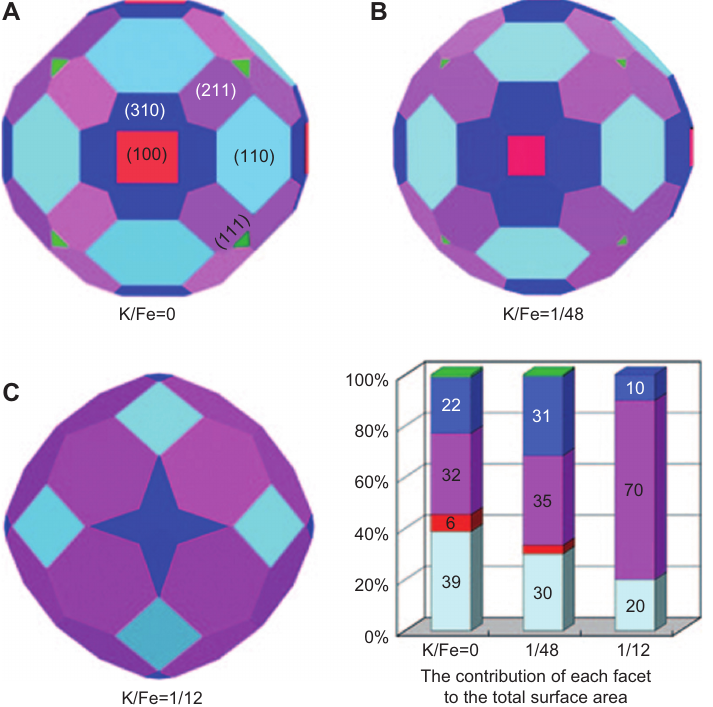
Figure 11 The effect of potassium contents on the Wulff shape of nanostructure Fe. The figures above show that the high index surface (211) are gradual domains of exposed surfaces of this Wulff shape (Reprinted from ref. [58]. Copyright (2011), with permission from John Wiley and